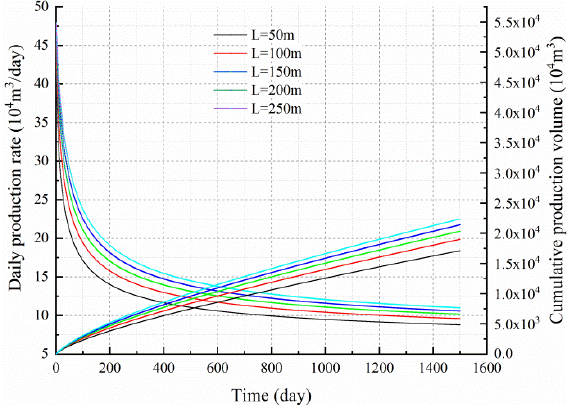
Figure 13. The e ff ect of di ff erent artificial fracture lengths on productivity. Figure 13. The effect of different artificial fracture lengths on productivity.